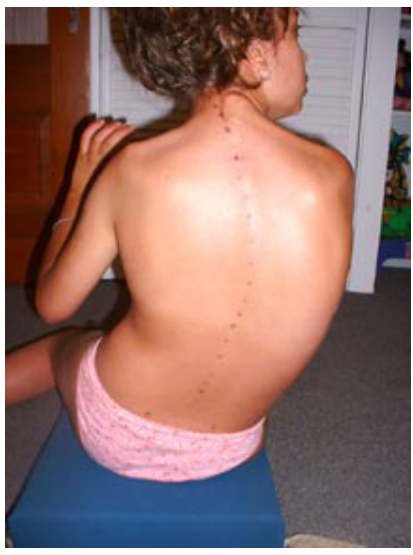
FIGURE 7. A child with RS and